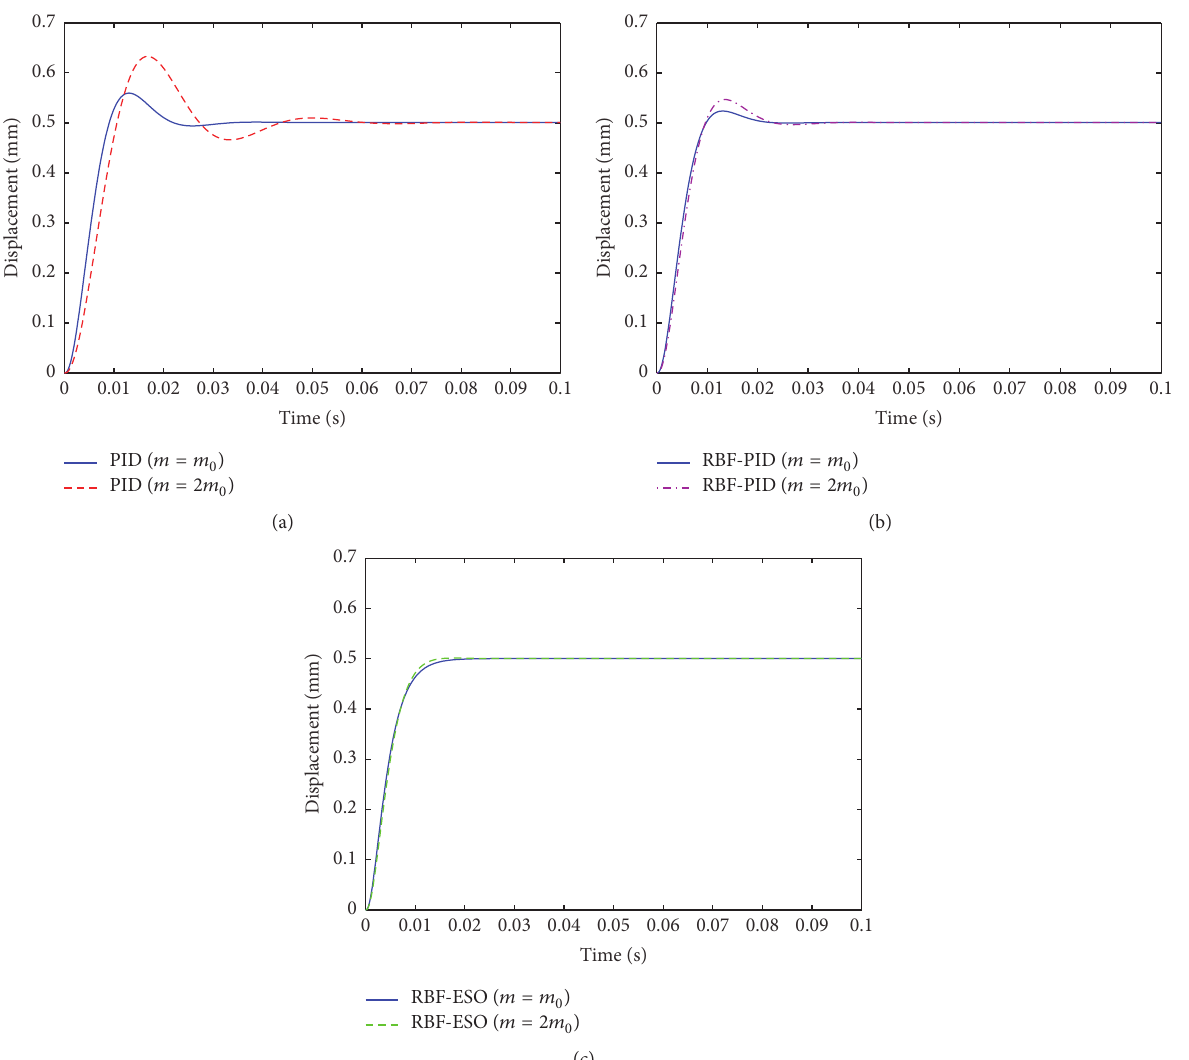
Figure 7: Robustness of different algorithms to diversification of the mechanical